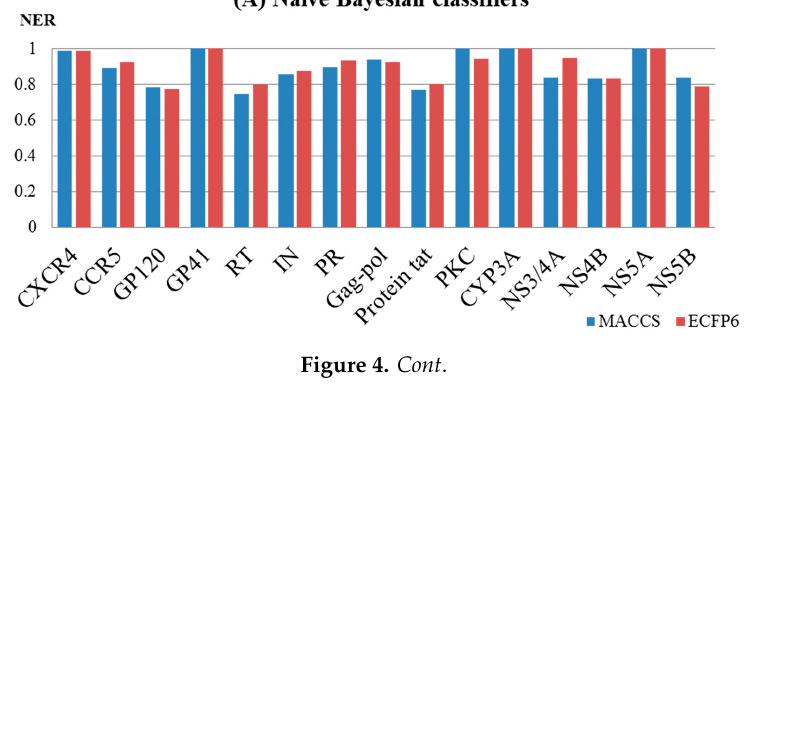
Figure 4. Performance of 60 multiple QSAR models built based on Naïve Bayes ( A ) and the support vector machine ( B ) using different fingerprints determined by test set validation.